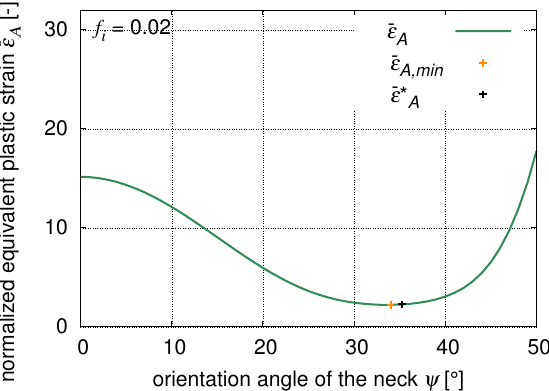
Figure 8. Variation of limit strains with respect to the angle of imperfection under uniaxial tension (strain normalized with respect to the mean uniform strain) [33].